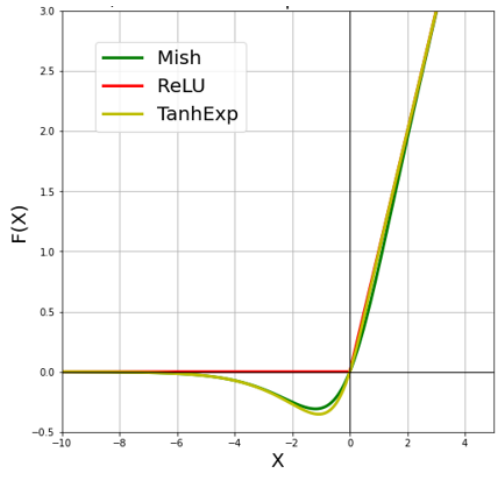
Figure 2. Graph of ReLU, Mish and TanhExp activation